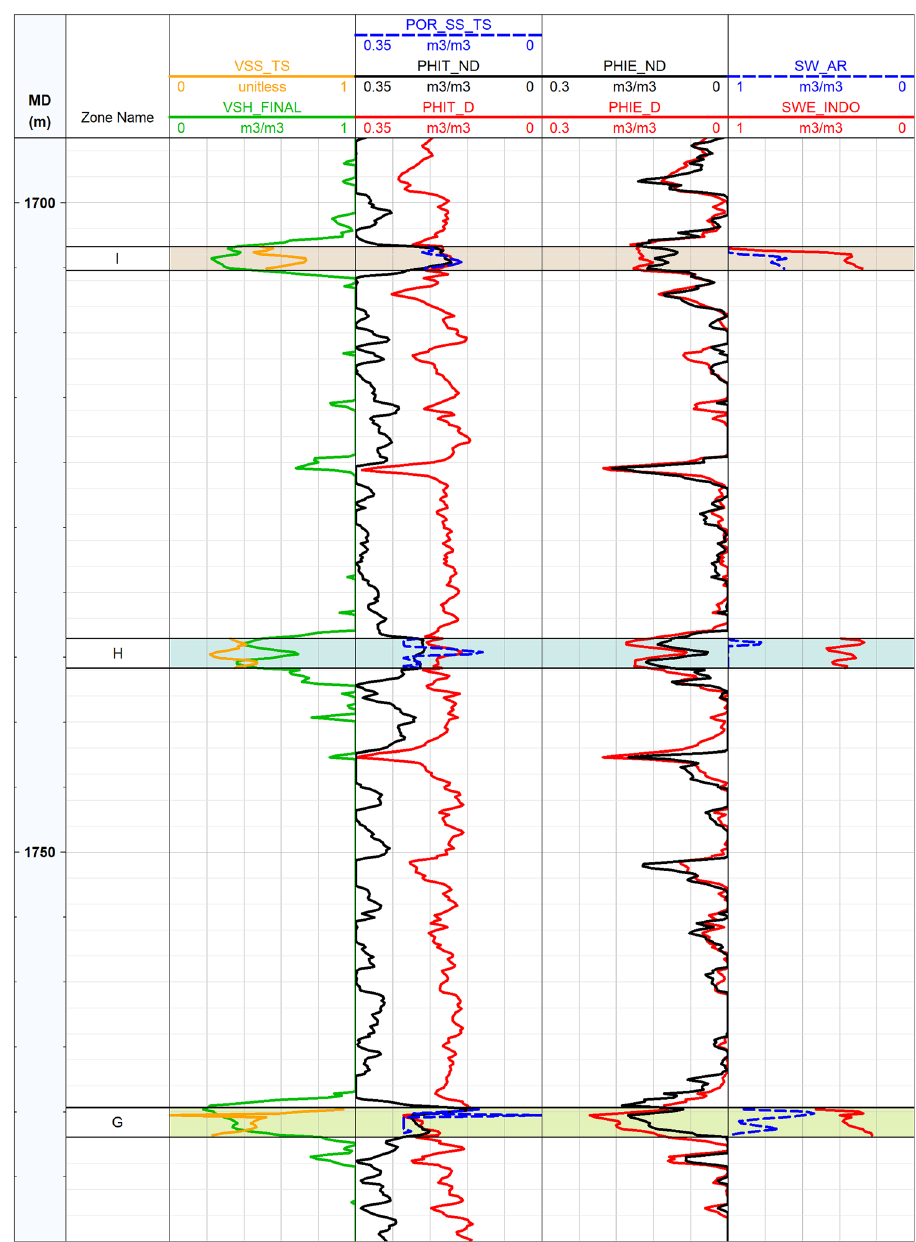
Fig. 9 Display of results in sam- ple zones. The parameters con- tained in the tracks from the left of the plot are measured depth (MD) in track 1; sand fraction from Thomas–Stieber method (VSS_TS) and shale volume (VSH_FINAL) in track 3. Sand porosity from Thomas–Stieber method (POR_SS_TS) and total porosity from neutron-density and density methods (PHIT_ ND, PHIT_D), respectively,